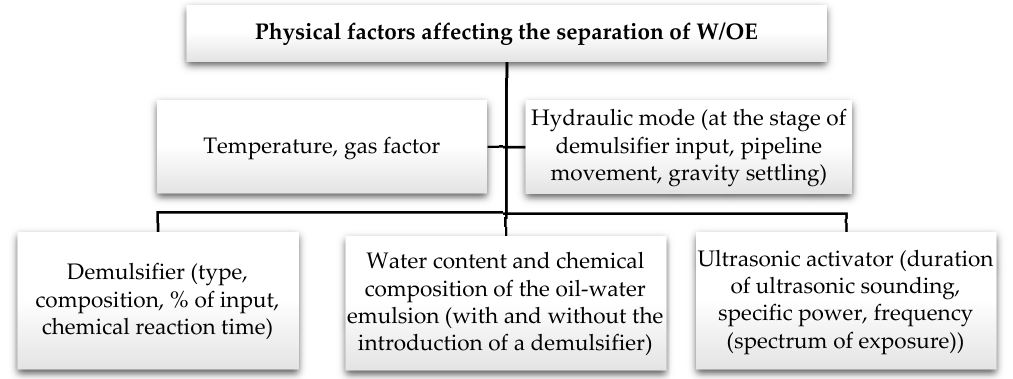
Figure 12. The main physical factors that have a significant impact on the process of separation of water-in-oil emulsions.